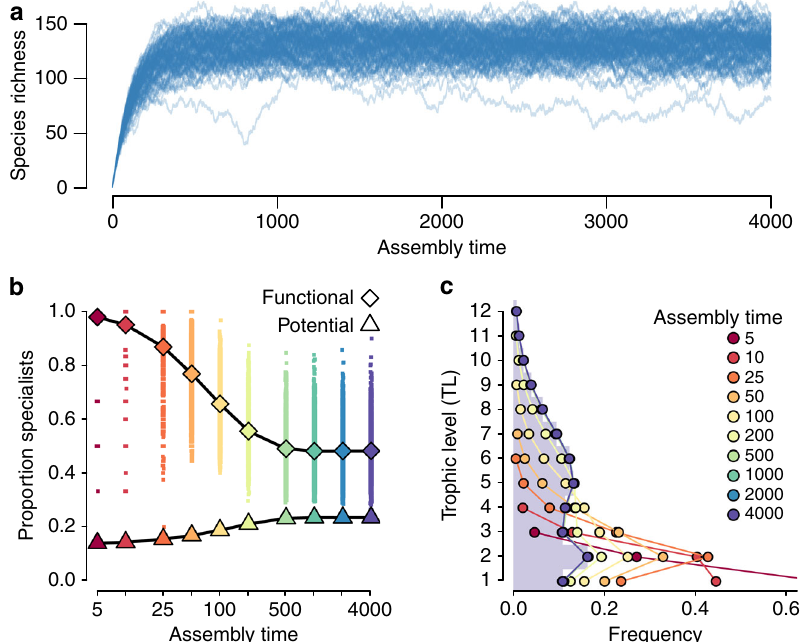
Fig. 2 Food web structure over the course of assembly. a Assembling communities over time from a pool of 200 non-engineering species. Steady state species richness is reached by t = 250. b The proportion of specialists as a function of assembly time (iterations). Diamonds denote expected values for functional (realized) trophic interactions at each point in time, and triangles denote expected values for potential trophic interactions (as if all trophic interactions with all species in the pool were realized), where the expectation is taken across replicates. Individual replicate results are shown for functional trophic interactions (small points). c The frequency distribution of trophic levels as a function of assembly time (iterations). Autotrophs occupy TL = 1. Measures were evaluated across 10 4 replicates; see “ Methods ” for parameter